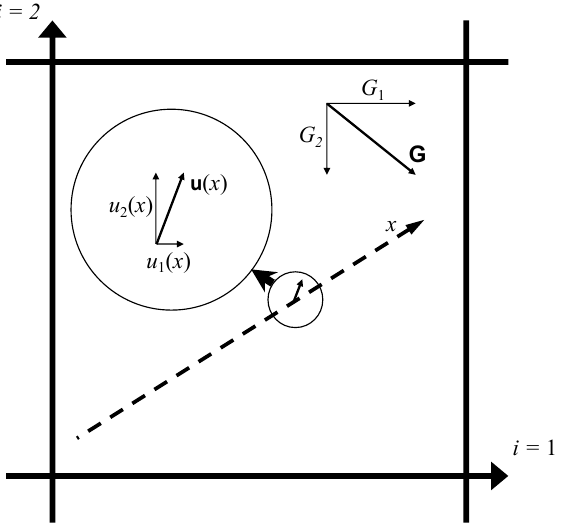
Figure 1. 2D rendering of a CV (thick solid lines), the associated ODT domain (dashed line), and their respective coordinate systems. The coordinates of the fixed Cartesian mesh of cubic CVs are labeled i , while x denotes the coordinate aligned with the ODT domain. The domain orientation is parallel to the time-varying domain-average velocity ¯ u = | ¯ u | ˆ¯ u , which defines the corresponding unit vector ˆ¯ u . The components of the ODT vector property profile u ( x ) are u ( x ) , where i = 1 and 2 in this i 2D illustration. The pressure gradient G = ∇ p has components G i = ˆ i · ∇ p where ˆ i is the unit vector aligned with coordinate i . G i is more intuitively (though unconventionally) denoted p , i in Equation (1) and elsewhere. For simplicity, a coarse-grained spatial discretization is assumed such that p , i is uniform in the CV and therefore uniform in x in Equation